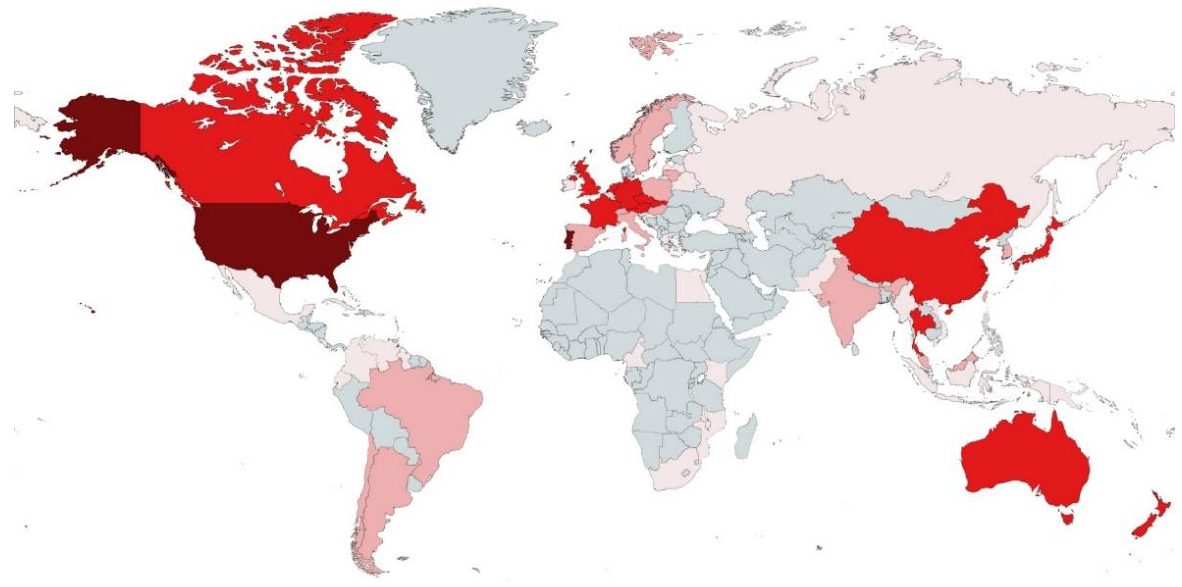
Figure 3. World map showing the countries of origin for strains/sequences of aquatic hyphomycetes used in this study. Colors indicate the number of different species obtained from each country: — more than 30; — from 11 to 29; — from 3 to 10; — less than 3 species; — zero species. North American and European countries had the highest number of species of aquatic hyphomycetes with available ITS barcodes: Portugal (34 species), United States of America (33 species), United Kingdom (29 species), Germany (28 species), France (22 spe- cies), and Czech Republic (21 species). These findings suggest that a larger effort isolating